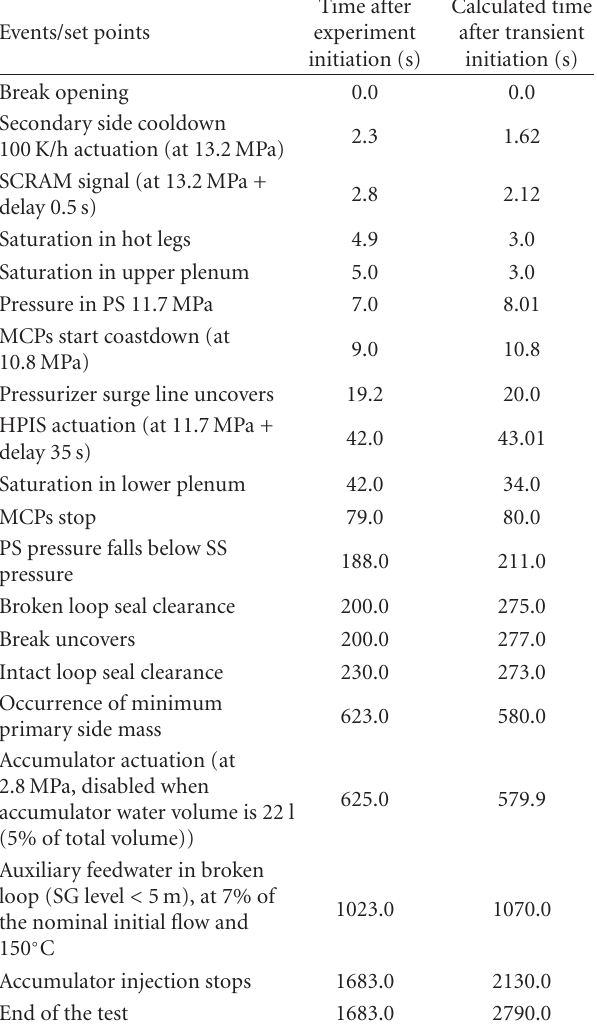
Table 2: Sequence of main events for test BL-30 experimental and posttest